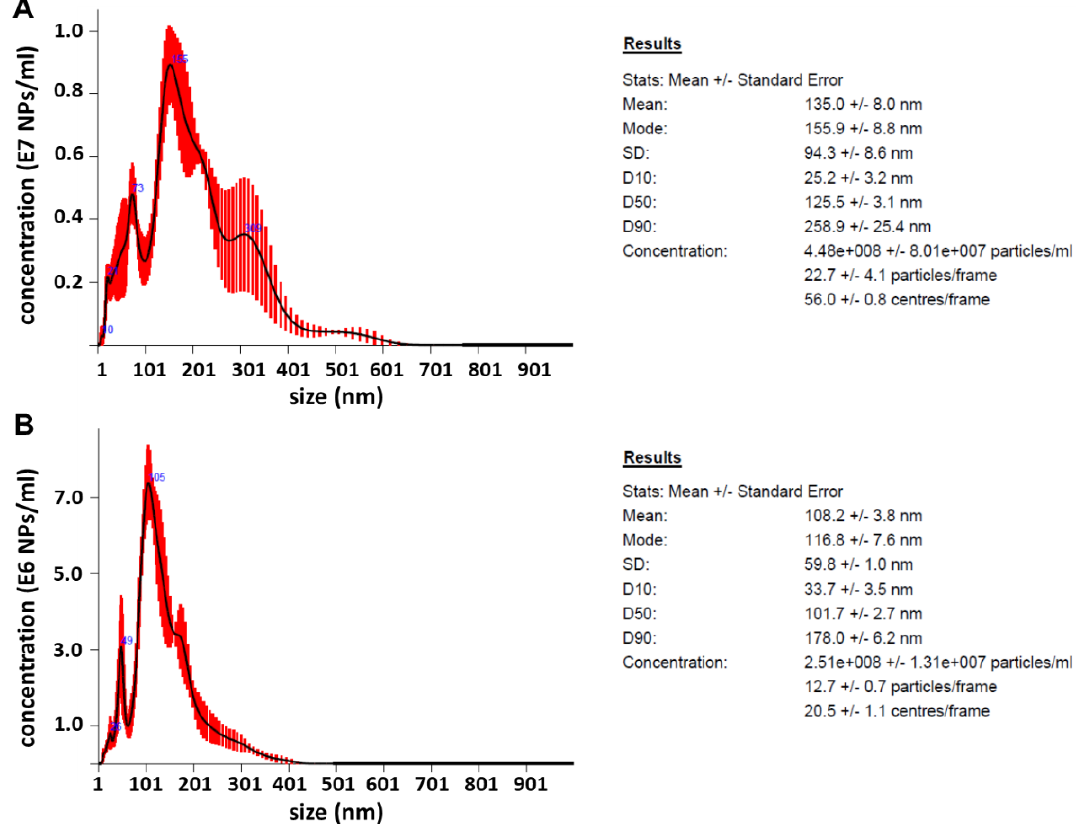
Figure 4. Nanoparticle tracking analysis results for ( A ) PdPt (I) and ( B ) PdPt (II) NPs.